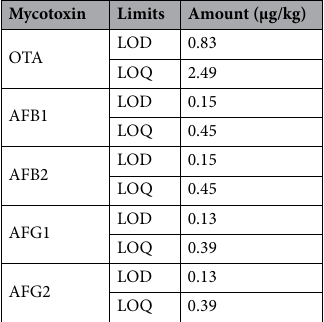
Table 2. Limits of Detection (LOD) and Quantification (LOQ) of ochratoxins (OTA) and aflatoxins (AFB 1 , AFB 2 , AFG 1 , AFG 2 , and AFtotal) (µg/kg) measured by HPLC. LOD-Limit of Detection. LOQ-Limit of